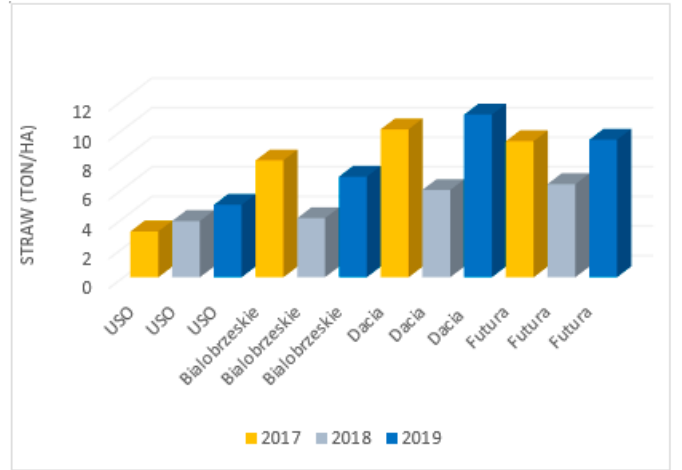
Figure 12. Mean yield of long fibre determined for different type of hemp cultivars: USO 31, Dacia Secuieni, Bialobrzeskie, Futura 75, cultivated for three consecutive years, based on [47].